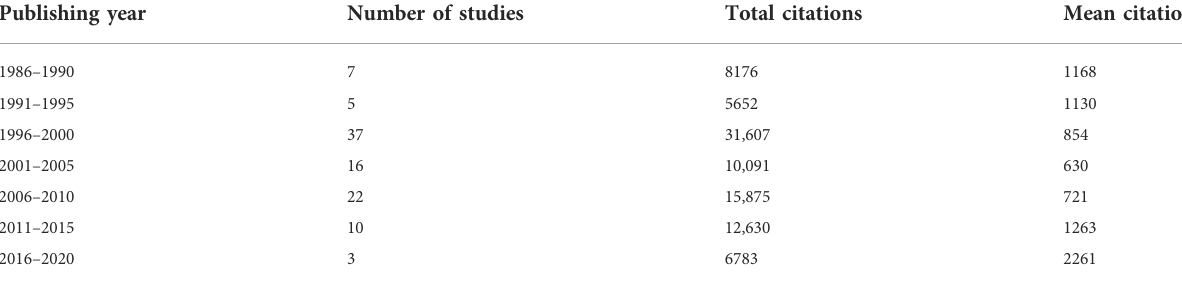
TABLE 3 5-years scienti fi c productions and citations.